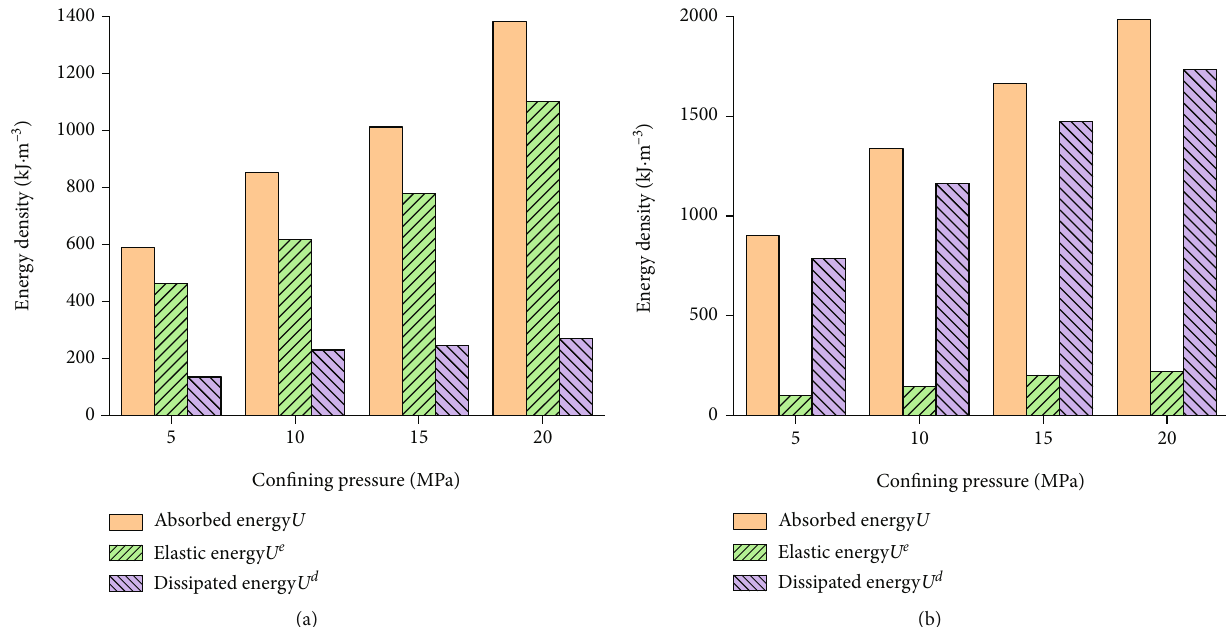
Figure 4: Energy distribution characteristics at di ff erent stages. (a) Prepeak stage. (b) Postpeak stage.